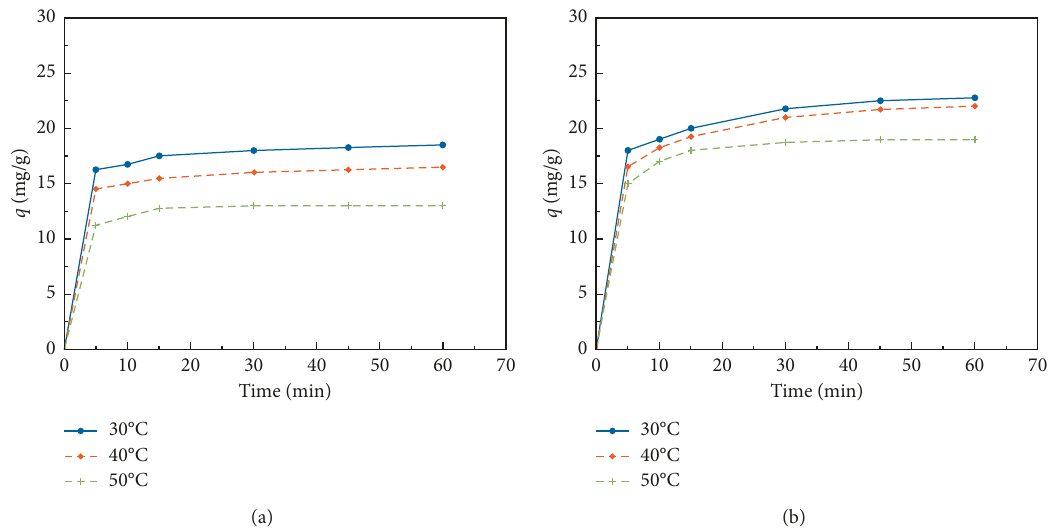
Figure 4: Effect of temperature on dye removal with (a) raw sawdust (conc.100mg/L; dose 4g/L) and (b) chemically treated sawdust (conc. 100mg/L; dose 4g/L).